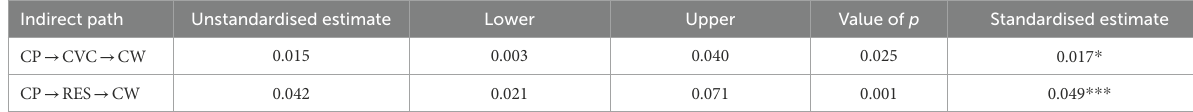
TABLE 5 Mediation table.